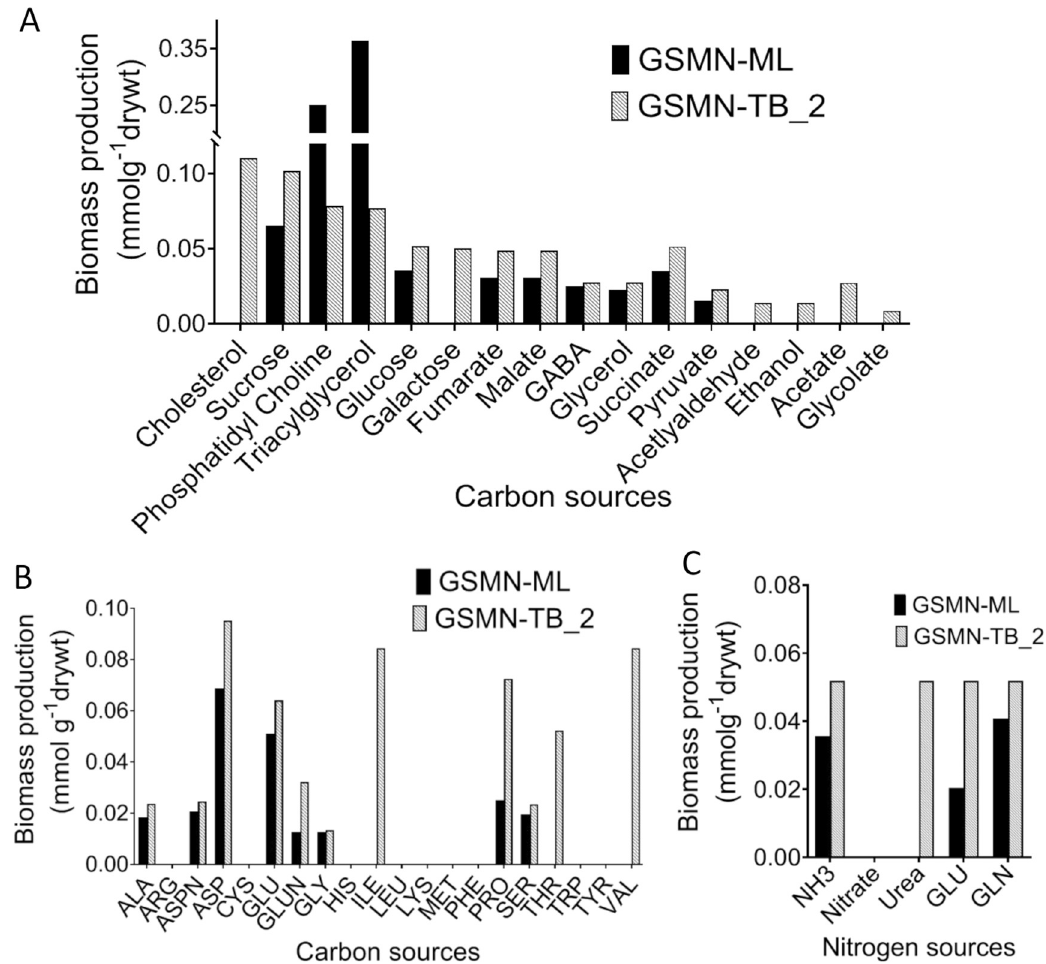
Fig 2. In silico prediction of biomass production for various substrates of M . leprae compared to the M . tuberculosis GSMN models. Carbon substrate utilization profiles of M . leprae GSMN-ML vs. M . tuberculosis GSMN-TB_2. Biomass production is shown for both the models on (A) various carbon substrates and (B) amino acids as carbon sources (C) various nitrogen sources. Biomass production flux was calculated on the various substrates using FBA. Abbreviations for amino acids are alanine (ALA), glycine (GLY), arginine (ARG), asparagine (ASPN) aspartic acid (ASP), cysteine (CYS), glutamic acid (GLU), glutamine (GLUN), histidine (HIS), isoleucine (ILE), leucine (LEU), lysine (LYS), methionine (MET), phenylalanine (PHE), proline (PRO), serine (SER), threonine (THR), tryptophan (TRP), tyrosine (TYR) and valine (VAL). of gene expression patterns [20]. The first step in DPA is to identify all genes (the metabolite producibility gene list) that are required (in the genome-scale model) for production of every metabolite, given a set of nutrients inputs. The next step in DPA is to interrogate gene expres- sion data to identify whether the genes that contribute to the production of a particular metab- olite tend to be associated with either up-regulated or down-regulated genes in the test condition. Note that metabolites may appear in both lists if, for example, one set of genes asso- ciated with their production is found to be up-regulated and another set is found to be down- regulated. In our previous study, we applied DPA to gene expression data obtained from both E . coli and M . tuberculosis , including M . tuberculosis replicating within macrophages [20]. In this study, we applied the same approach to investigate metabolic changes associated with in vivo growth of M . leprae .